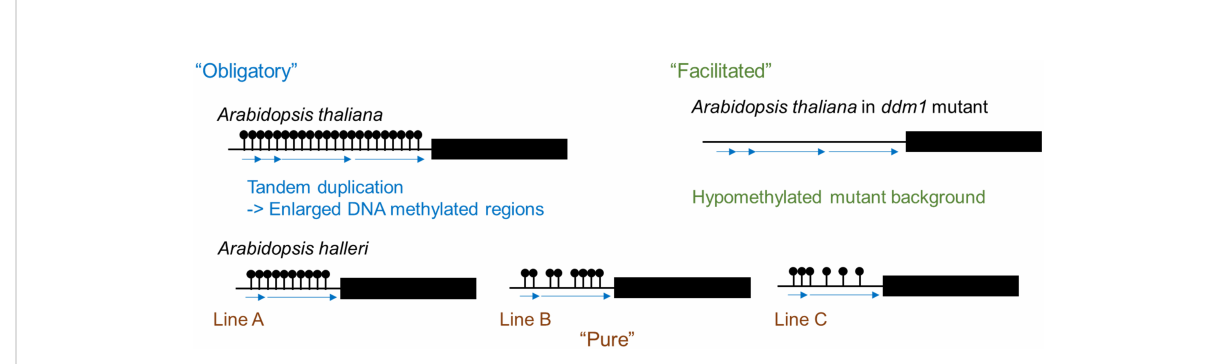
FIGURE 1 Three classes of epigenetic variation. Variation of DNA methylation results in the formation of tandem repeats ( “ Obligatory ” ). Demethylation is observed in hypomethylated mutants such as ddm1 ( “ Facilitated ” ). Natural variations in DNA methylation levels even without any DNA sequence differences between lines ( “ Pure ”